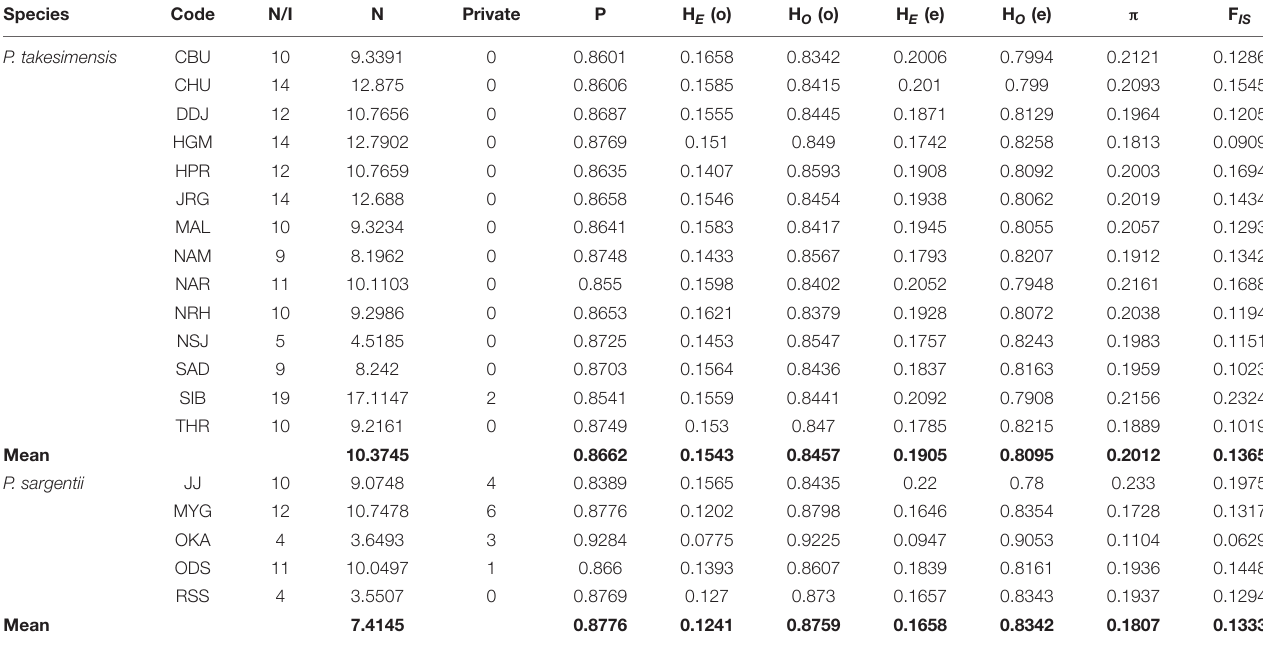
TABLE 4 | Molecular diversity indices estimated in the populations of the insular derivative, P. takesimensis, and continental progenitor species, P. sargentii , based on MIG-seq SNPs.